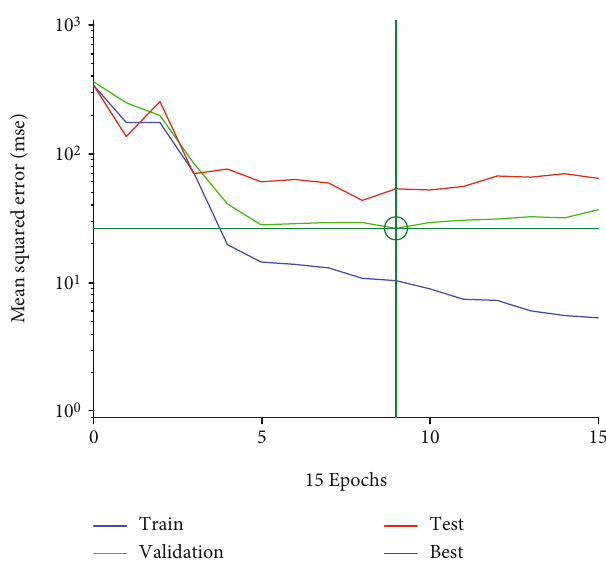
Figure 3: MSE of proposed method during